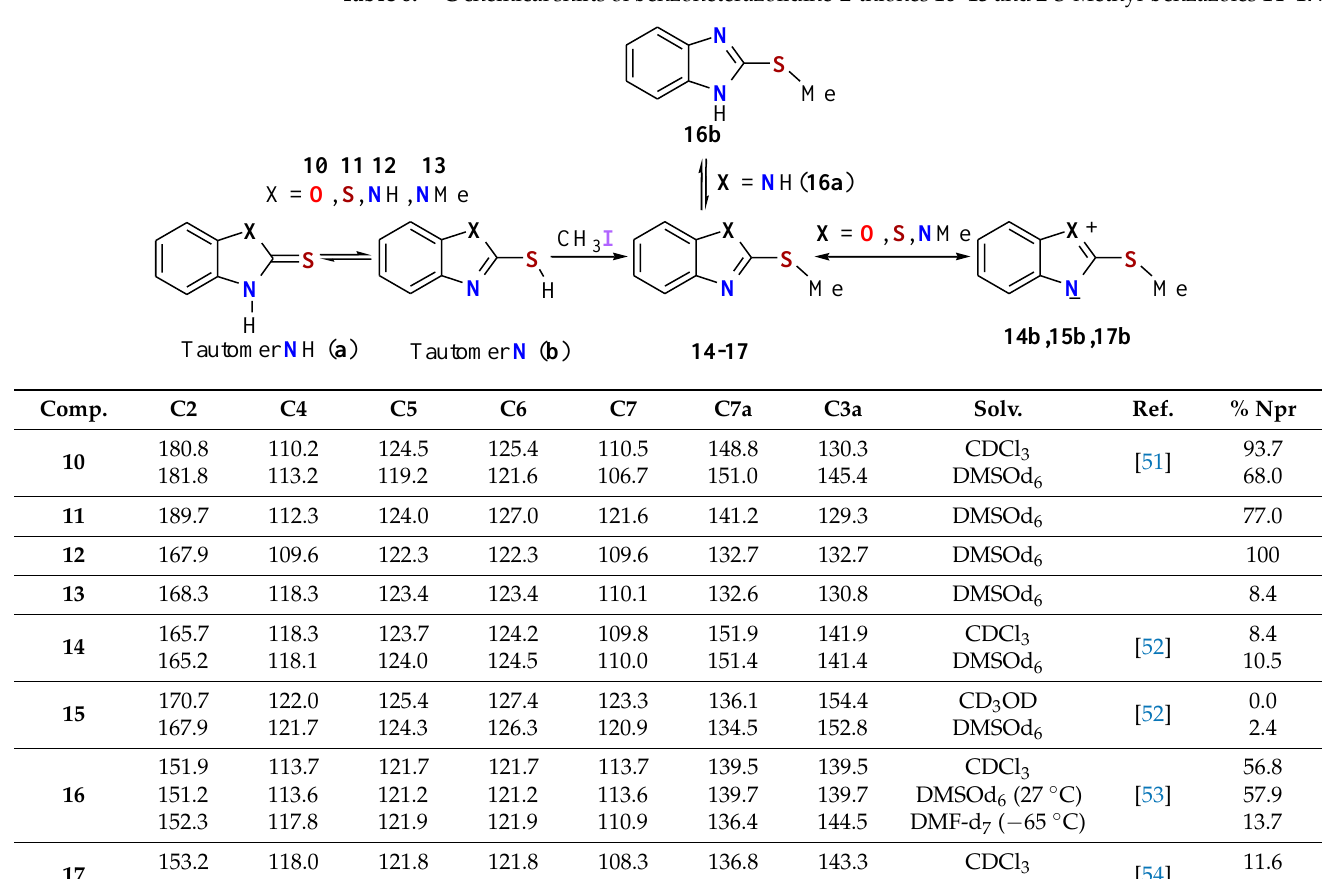
Table 6. 13 C chemical shifts of benzoheterazolidine-2-thiones 10 – 13 and 2-S-Methyl-benzazoles 14 – 17 .